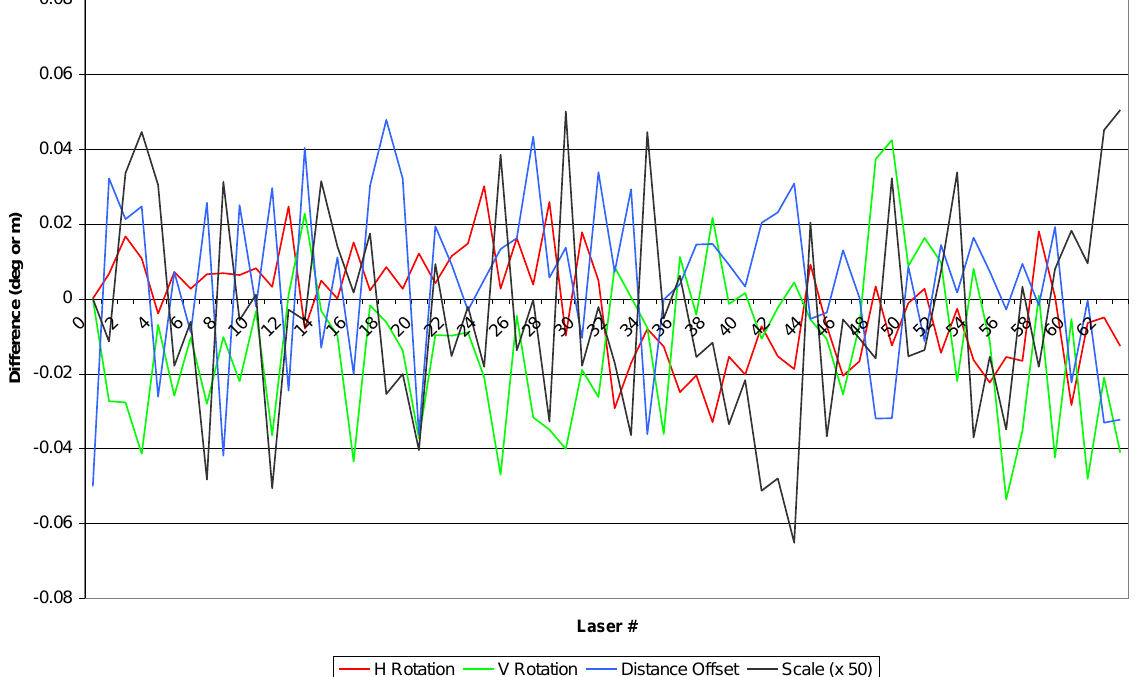
Figure 5. Temporal Calibration Differences between Observation Sets for Laser 1. Laser 1 - Temporal Calibration